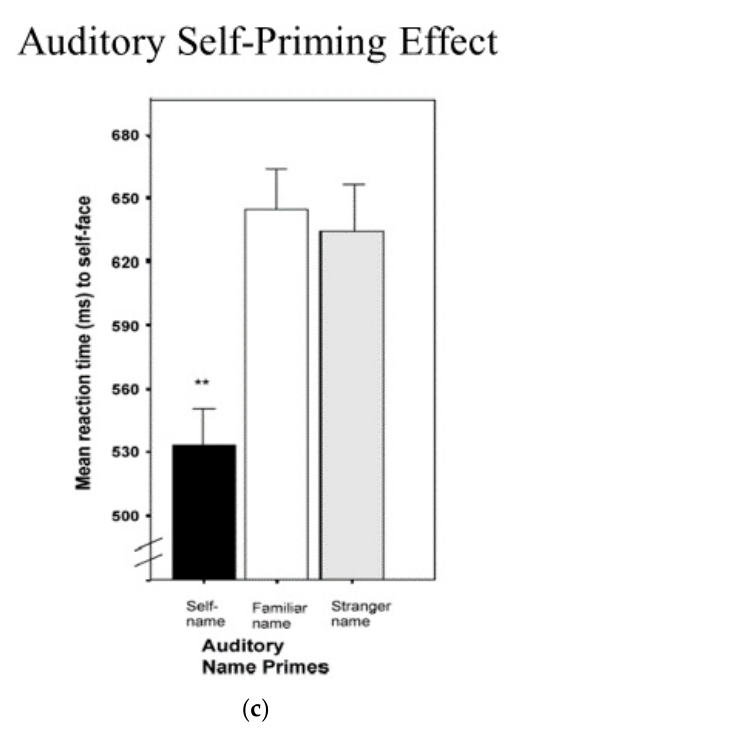
Figure 4. ( a ) Olfactory priming results; ( b ) Visual self-name priming; and ( c ) Auditory self-name priming (** p < 0.01) .